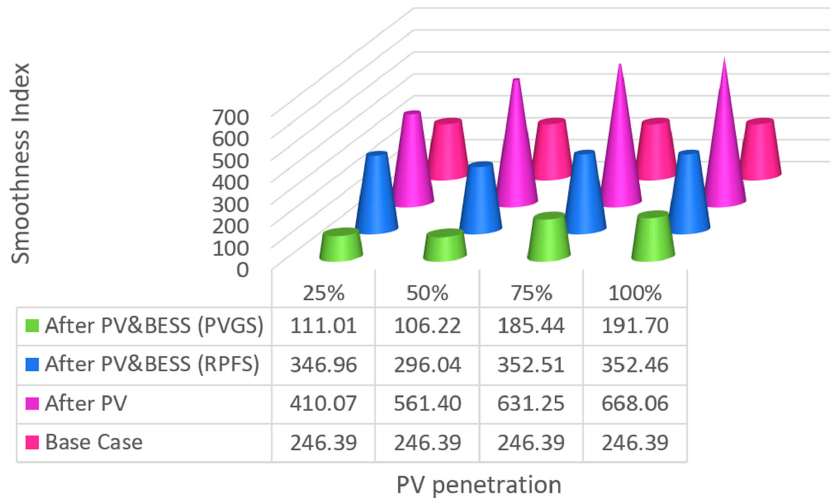
Figure 18. Smoothness index (SI) comparison before and after BESS in the presence of PV generation for PVGS. Table 5. Comparison of the